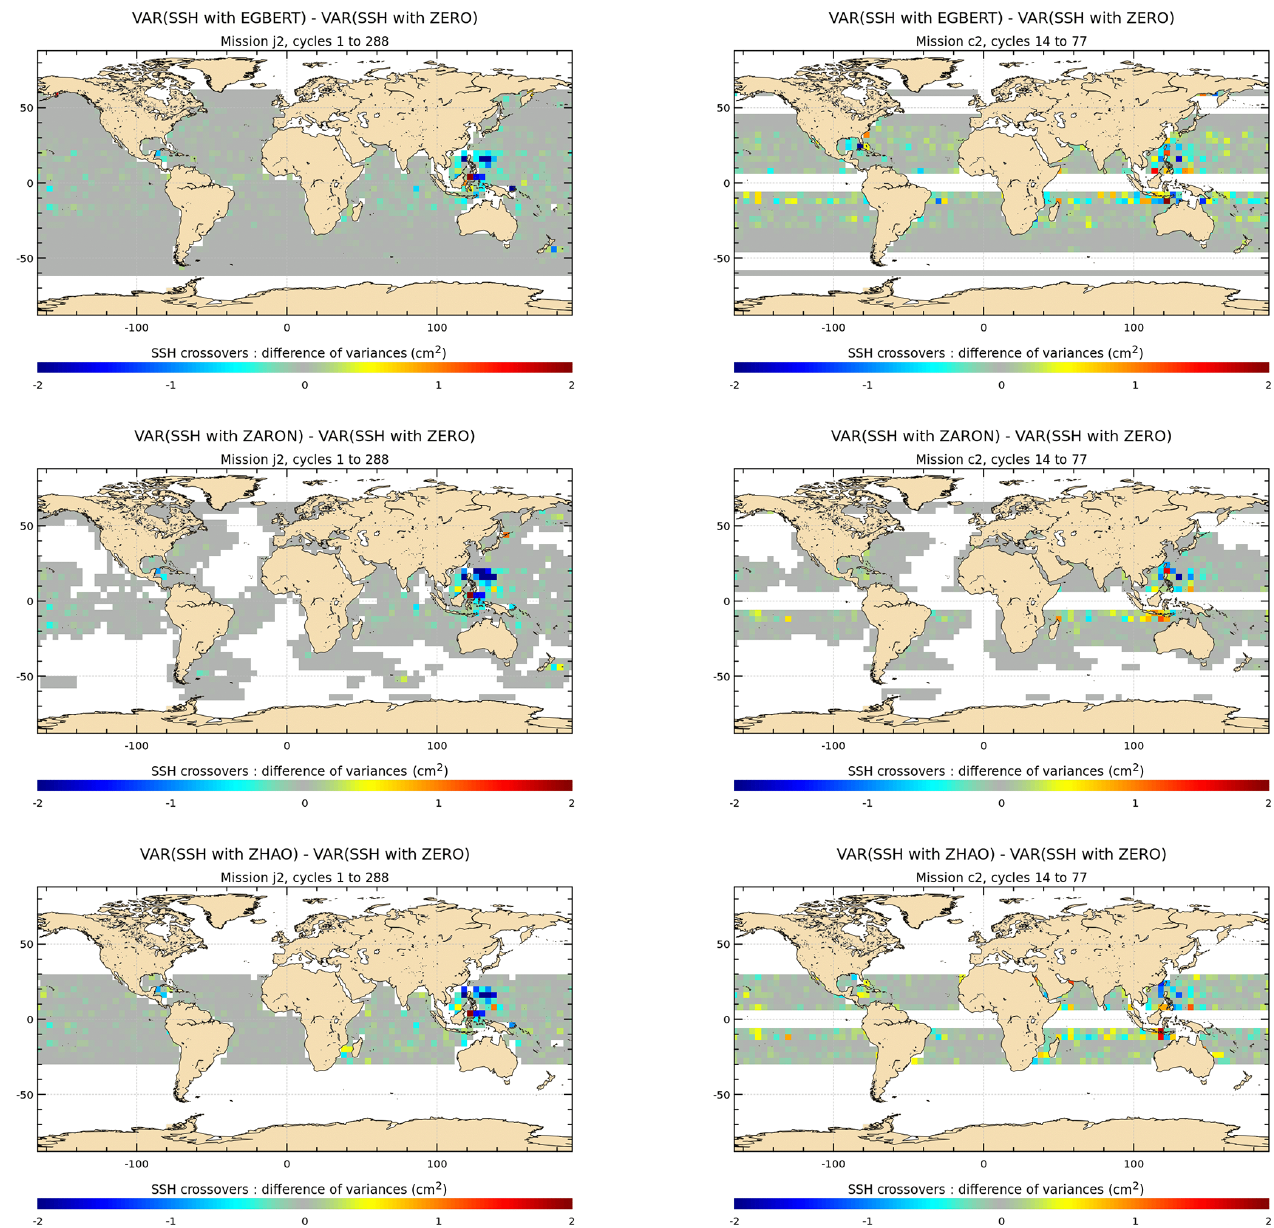
Figure B2. Maps of SSH variance differences at crossovers using either the O 1 IT correction from each model or a reference ZERO correction in the SSH calculation for the J2 and C2 missions (cm 2 ). J2 cycles 1–288 have been used; C2 cycles 14–77 have been